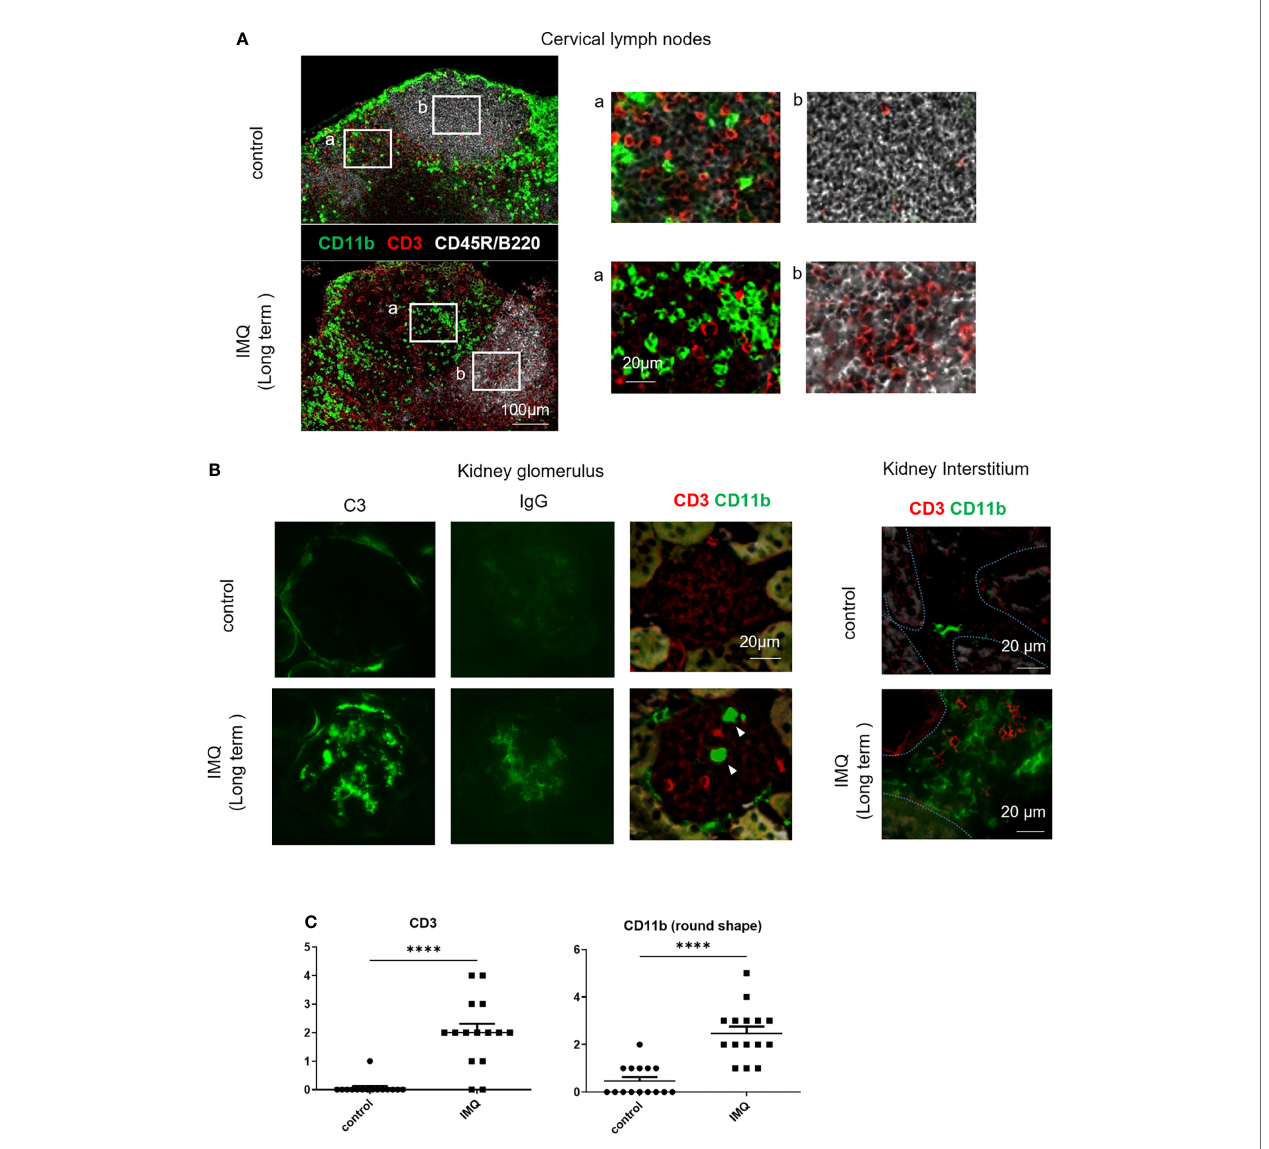
FIGURE 2 | Immuno fl uorescent staining of cervical lymph nodes and kidneys of IMQ-induced lupus mice. Mice were treated with 40 mg of IMQ three times a week for 5 weeks. Frozen sections were stained with the indicated antibodies. (A) Immuno fl uorescent staining of cervical lymph nodes from control and IMQ-induced lupus mice. (B) Immuno fl uorescent staining of kidneys from control and IMQ-induced lupus mice. Arrowheads indicate round cells in the glomeruli. Dashed lines in the right panel outline the tubular epithelium. (C) CD3 + and CD11b + round cells in fi ve representative glomeruli were counted twice from three mice. Cell number per glomerulus is shown. (A, B) are representative images of two experiments (n=3). ****P < 0.0001 by Student ’ s t -test. T cell zones (a) and follicles (b) were magni fi